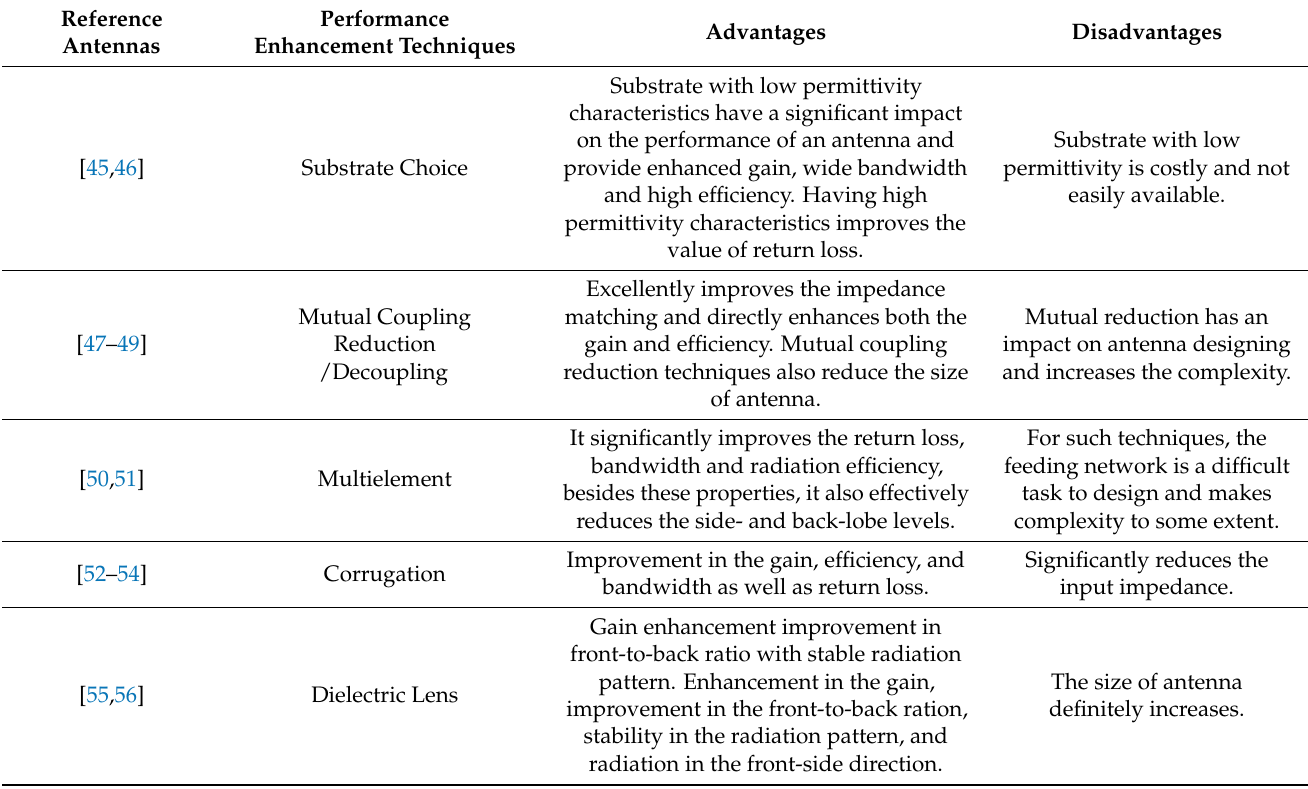
Table 1. Performance Enhancement Techniques: Advantages and Disadvantages.